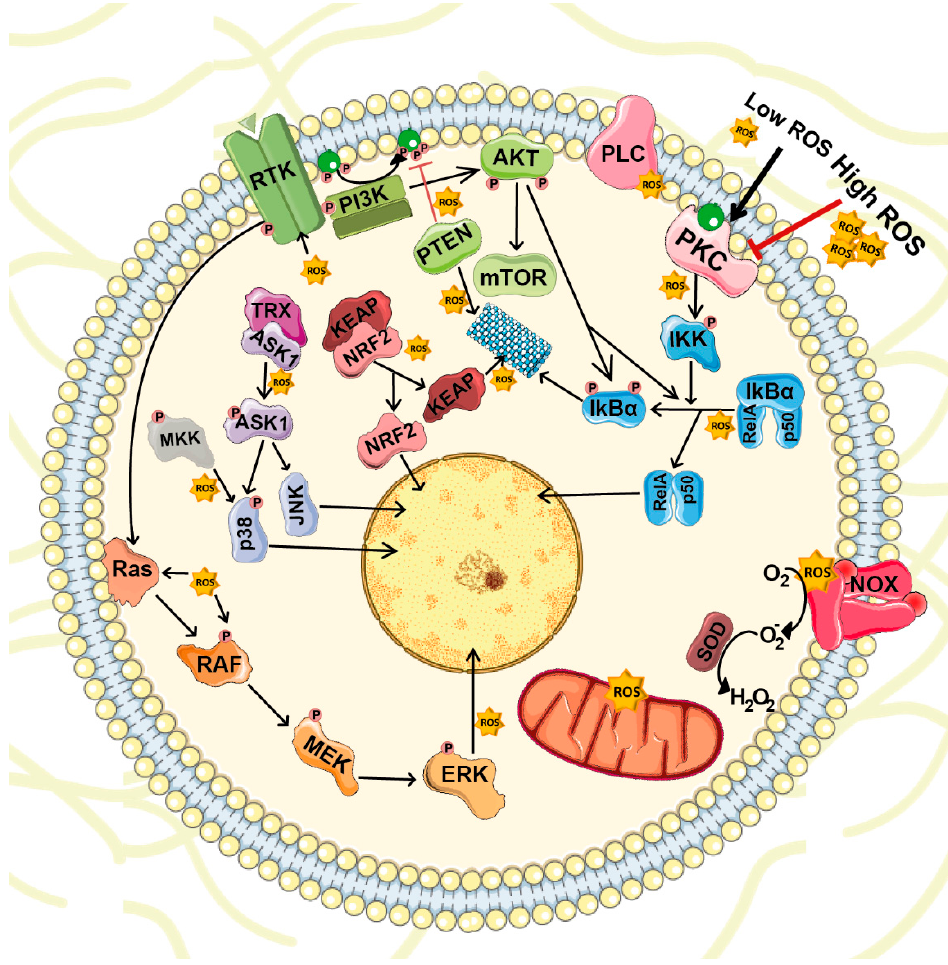
Figure 2. ROS-mediated cellular signaling. ROS are highly reactive molecules that act as second messengers inside the cell. Besides mitochondrial respiration, NOXs represent the major ROS source. Under physiological conditions, intracellular ROS target and stimulate several transductor proteins NF- κ B, MAPKs, KEAP1-NRF2 and PI3K-AKT important for cell survival, proliferation and differentiation.